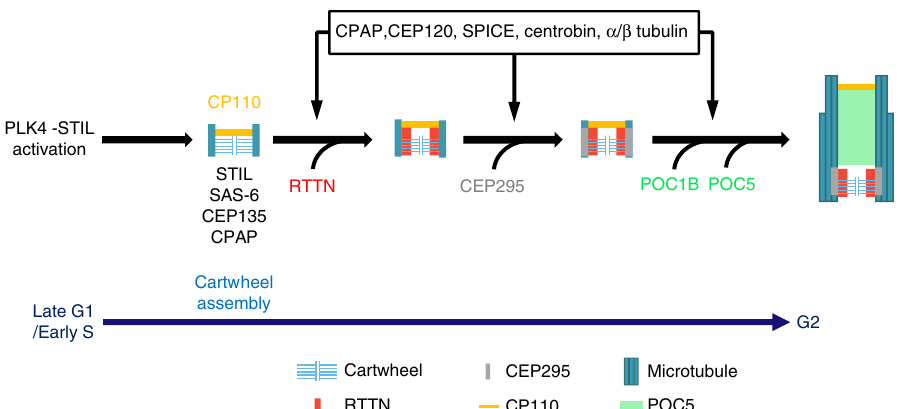
Fig. 8 Model showing the role of RTTN in procentriole elongation. During early S phase, RTTN is recruited to the inner luminal wall of newborn centrioles, where it likely stabilizes and maintains the primitive procentrioles. RTTN then helps recruit CEP295, which mediates procentriole elongation and promotes the loading of POC5/POC1B to the distal-half centrioles. CPAP and CEP120 promote the assembly of outer 9-triplet microtubules. For details, see the Discussion. For simplicity, only one centriole